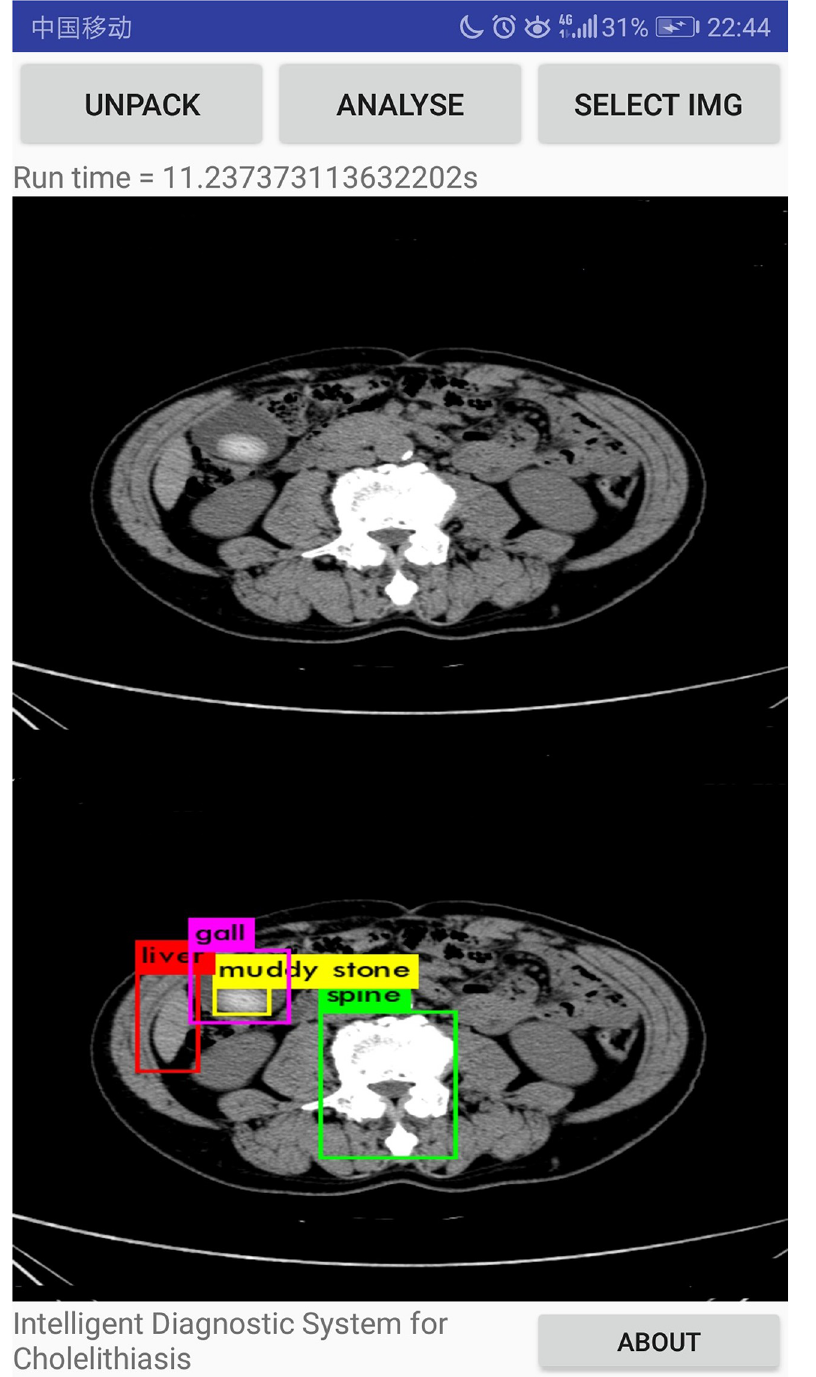
Fig 13. The experimental results that muddy stone is